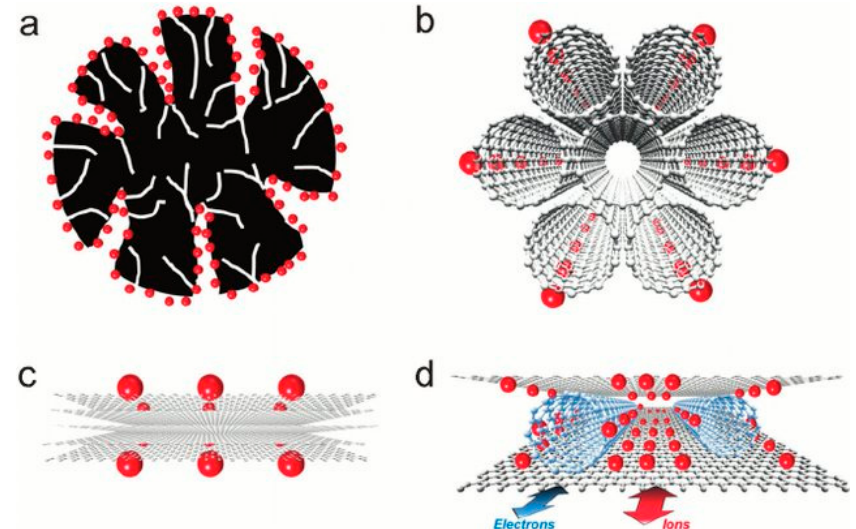
Figure 3. Different form of carbon used in supercapacitors. ( a ) Activated porous carbon. ( b ) Single-walled carbon nanotube (SWCNT) bundles. ( c ) Pristine graphene. ( d ) Graphene/CNT composite. Used with permission of ROYAL SOCIETY OF CHEMISTRY, from [15]; copyright (1999), permission conveyed through Copyright Clearance Center, Inc.